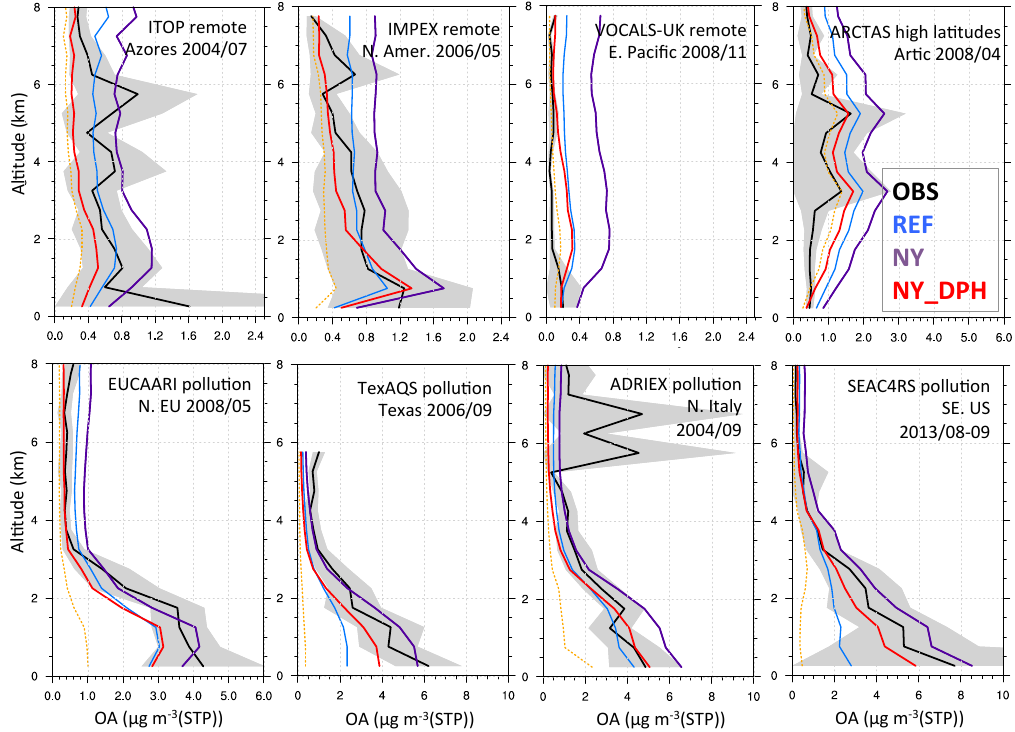
Figure 6. Comparison of mean OA vertical profiles (µgm − 3 (STP) at 273.15K and 1013.25hPa) measured during recent aircraft field campaigns (see Table S5) with the corresponding GEOS-Chem predictions from three simulations including REF (blue), NY (purple) and NY_DPH (red). Concentrations of primary OC are also shown (dashed orange line) and are similar in all model runs. Flights in remote or high latitude (top row) and moderately polluted (bottom row) regions are shown. Variability around observed values (2 standard deviations) at each altitude are shown with shaded area. For ARCTAS, the observed OA concentrations above the 99th percentile, i.e., larger than 16µgm − 3 (STP), were filtered out to limit the influence of biomass burning plumes. For SEAC4RS the observations of acetonitrile were used to filter out fire plumes, and data above the 80th percentile ( ∼ 140ppt) of observed acetonitrile concentrations were excluded. The model simulations are sampled for the year, month and locations of each aircraft campaign except for two campaigns including ITOP and ADRIEX for which average values between 2005 and 2008 are used for the month matching the field